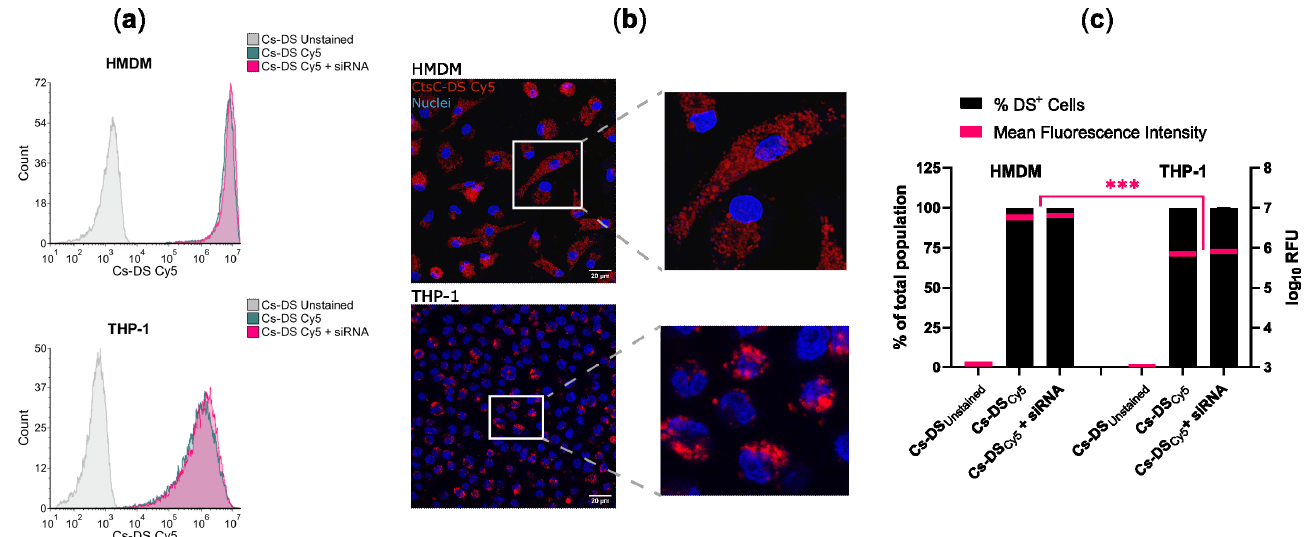
Figure 3. Cs-DS is effectively internalized by human monocyte-derived macrophages and THP-1 macrophages. Macrophages were treated for 6 h with Cy5-labeled empty Cs-DS or siRNA-loaded DSs, and their NP content was analyzed using ( a ) flow cytometry and ( b ) confocal microscopy: ( a ) flow cytometry histograms were obtained from one representative experiment; ( b ) confocal images from one representative experiment. DSs labeled with Cy5 are shown in red, and the cell nuclei labeled with DAPI are in blue; ( c ) the bar plot represents the percentage of macrophages loaded with DSs (left y-axis), and the red lines within the bars represent the mean fl uorescence intensity of DSs per macrophage (right y-axis) calculated from three independent samples via fl ow cytometry. The thickness of the red lines represents min/max data dispersion. *** p ≤ 0.001.